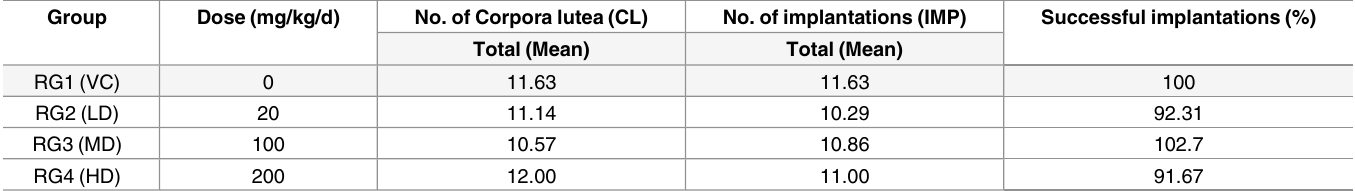
Table 9. Corpora lutea and implantation sites in numbers in reproductive/ developmental toxicity study in Wistar rats. Group